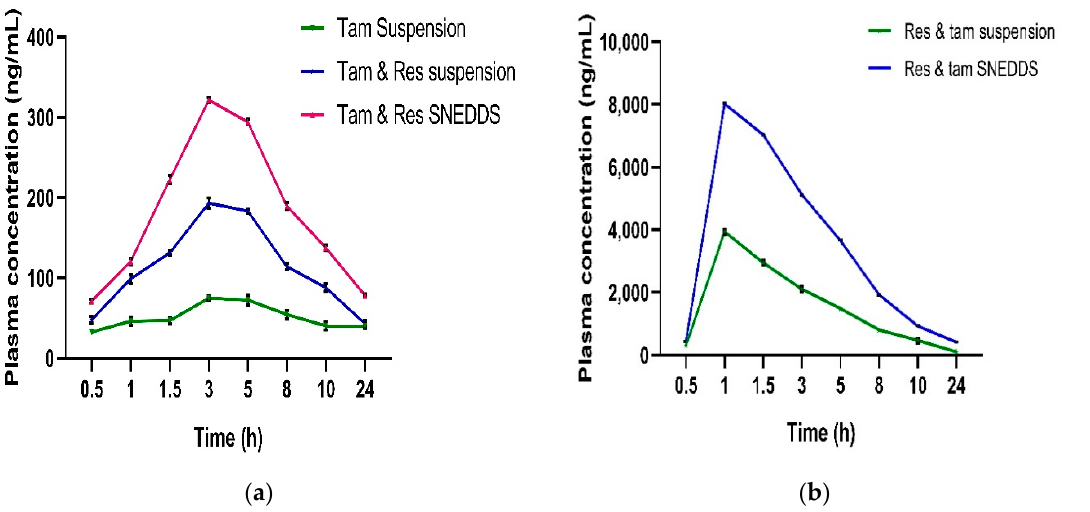
Figure 10. Plasma concentration time profile of ( a ) TAM and ( b ) RES after oral administration of their SNEDDS and suspension. Data expressed as mean ± SD, n = 6.